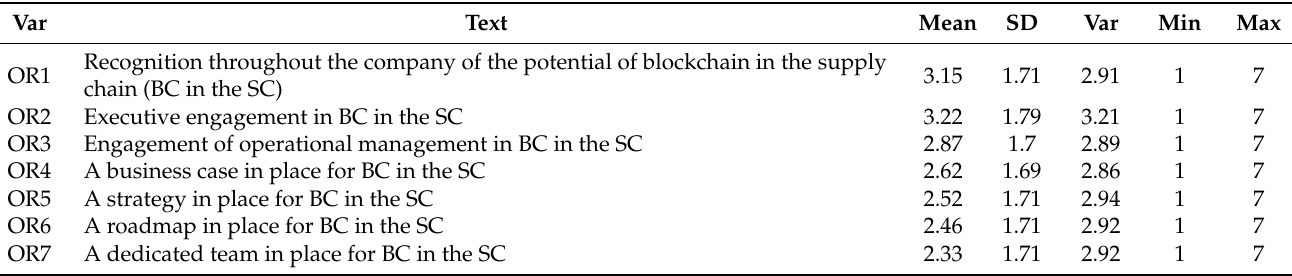
Table A2. Organizational readiness. To what degree does your company have . . .